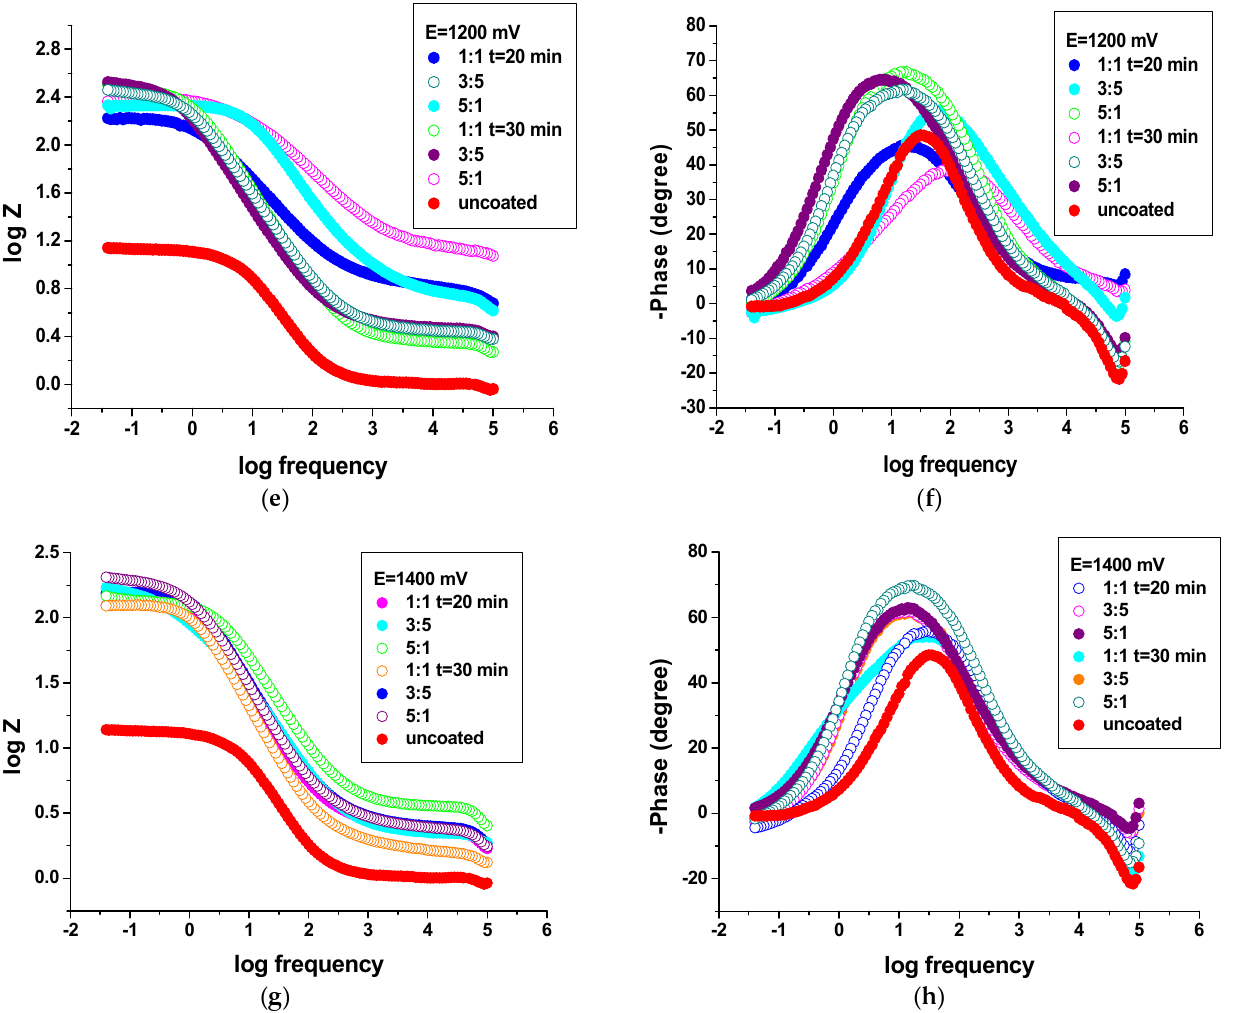
Figure 9. Bode diagrams for uncoated and PNMPY-TW20/P3MT-coated OLC 45 sample by galvanostatic, at ( a , b ) 3 mA/cm 2 and ( c , d ) 5 mA/cm 2 current density, and potentiostatic, at 1.2 V ( e , f ) and 1.4 V ( g , h ) potential, procedures with diverse molar ratio for PNMPY-TW20 and P3MT.